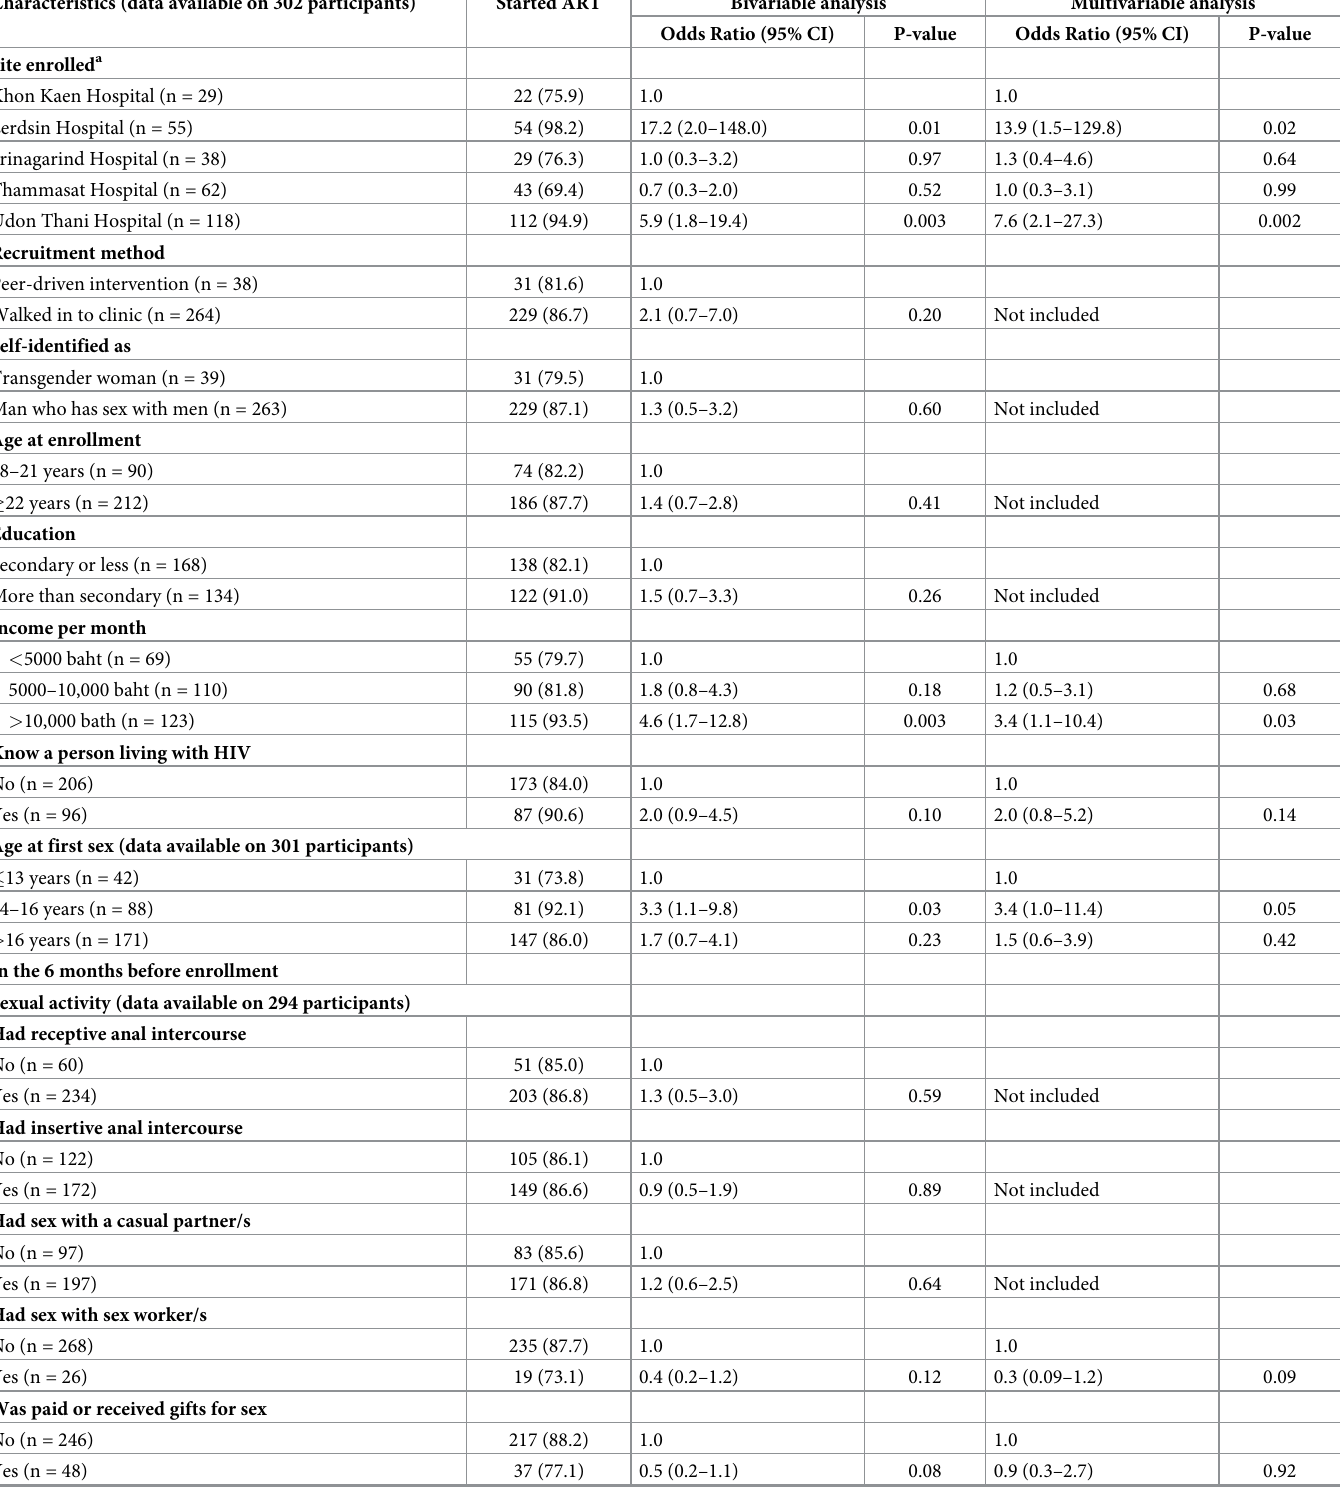
Table 4. Results of logistic regression analysis evaluating characteristics of participants in the test, treat, and prevent HIV program with prevalent HIV infection who chose to start antiretroviral therapy (ART), Thailand, 2015–2016. Characteristics (data available on 302